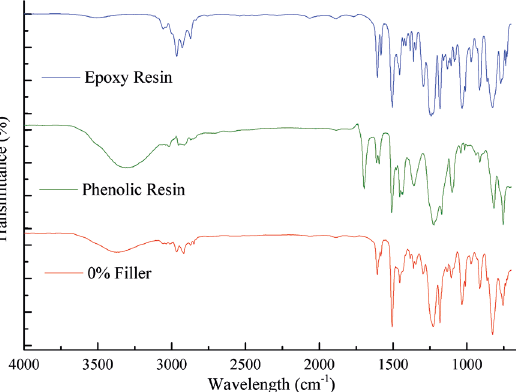
Figure 2. FTIR spectra of the epoxy resin, phenolic resin, and 0% filler mixture